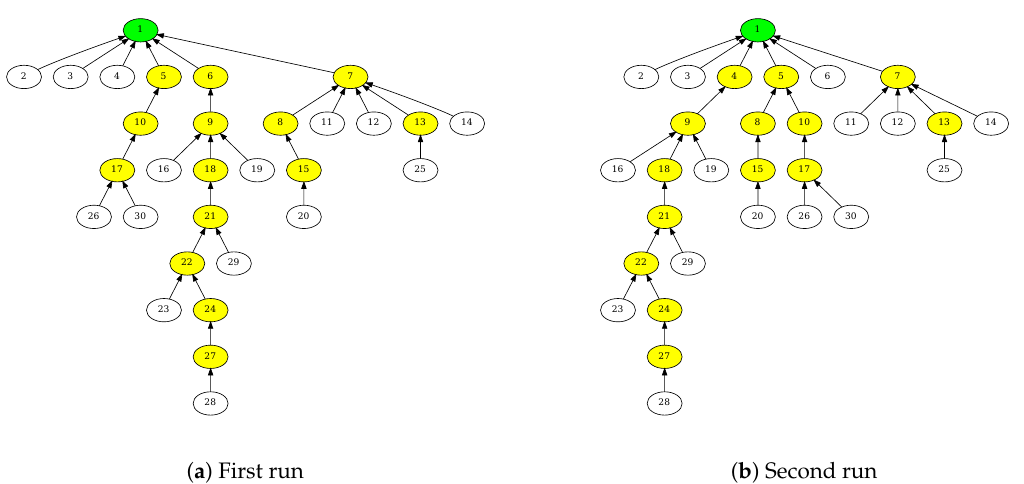
Figure 7. Different routing trees are created by the RPL protocol in different simulation runs.